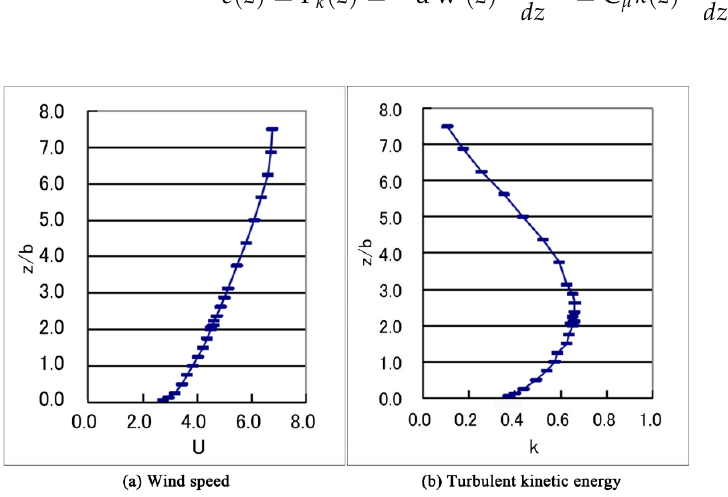
Figure 3. Wind speed and turbulent kinetic energy measurements. Outlet boundary: The normal gradients of all variables were set to zero for the out- flow